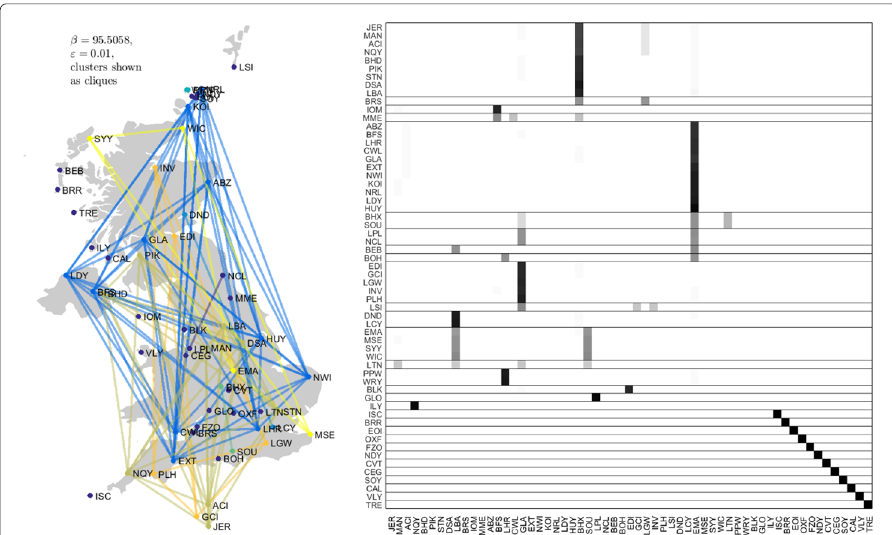
Fig. 11 Clusters from UK flight data for Sunday, 24 October 2010; otherwise as in Fig. 5. Cluster colors only distinguish clusters from each other and do not suggest affinity across